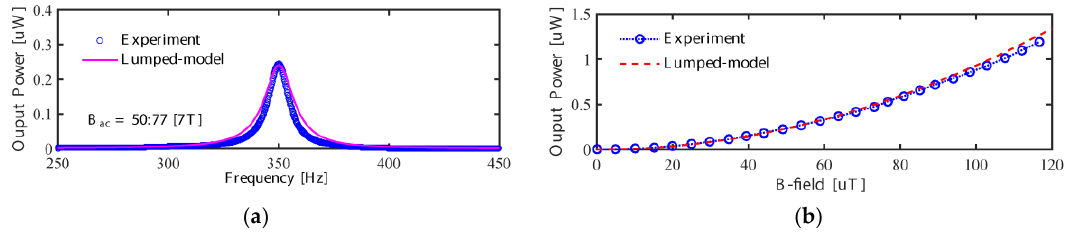
Figure 13. ( a ) Experimental and modeled MME transducer power output across frequency. ( b ) Experimental and modeled MME transducer power output under varying magnetic field at 350 Hz operating frequency. (Reproduced from [18] with permission.).